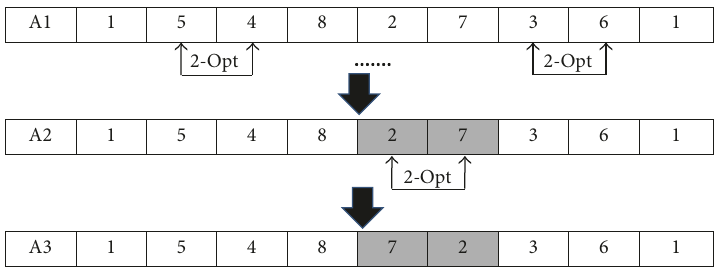
Figure 6: The example of 2-Opt operation.